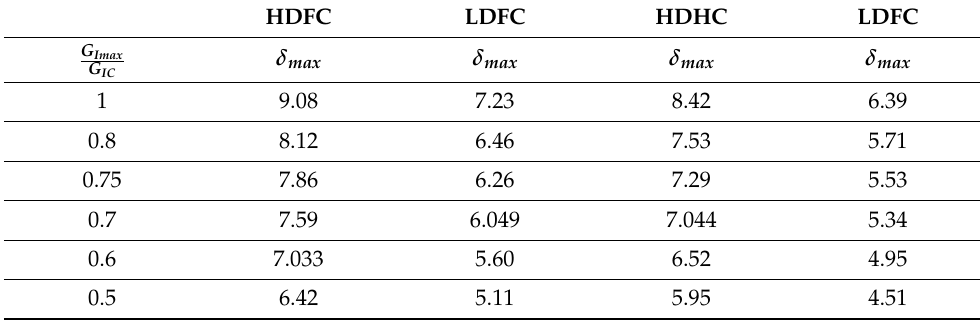
Table 6. δ max values calculated for the different sandwich configurations.